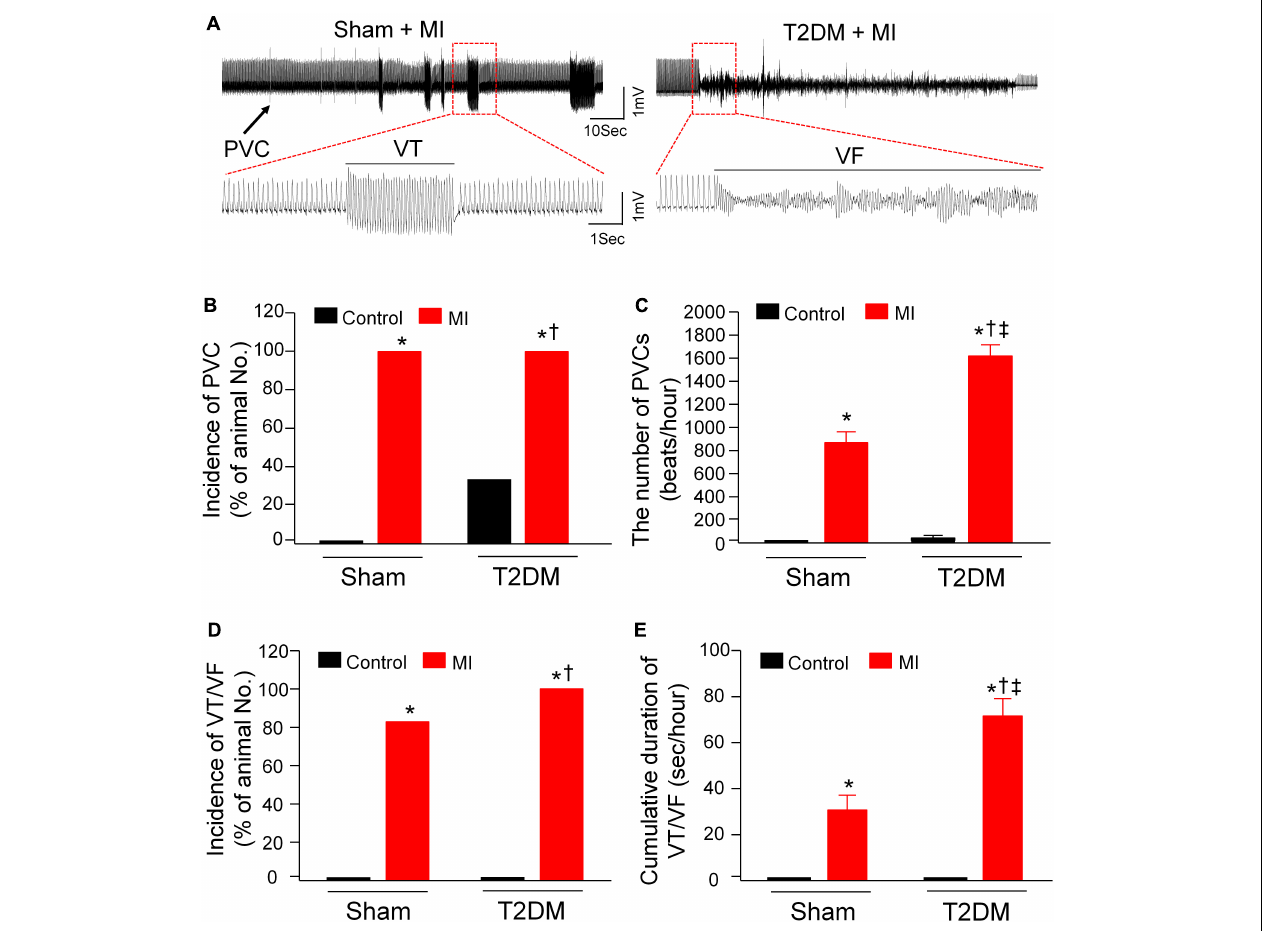
FIGURE 2 | Spontaneous ventricular arrhythmias in all experimental groups of conscious rats. (A) : Raw ECG recordings for premature ventricular contractions (PVCs) and ventricular tachycardia/fibrillation (VT/VF) in conscious sham and T2DM rats within 24 h after MI. (B–E) : Mean data for incidence of PVCs (B), number of PVCs (C) , incidence of VT/VF (D) , and cumulative duration of VT/VF (E) in all groups of conscious rats. No PVCs and VT/VF were observed in sham rats, whereas a few PVCs but not VT/VF were detected in some T2DM rats without MI. MI induced significant increases in the number of PVCs and the cumulative duration of VT/VF in T2DM rats, compared with sham+MI. Statistical significance was determined by a Chi-Square test for data presented in panel (B) and (D) . Statistical significance was determined by one-way ANOVA with post-hoc Bonferroni test for data presented in panel (C,E) . Data are means ± SEM; n = 6 rats per group.* P < 0.05 vs. sham; † p < 0.05 vs. T2DM; ‡ p < 0.05 vs.